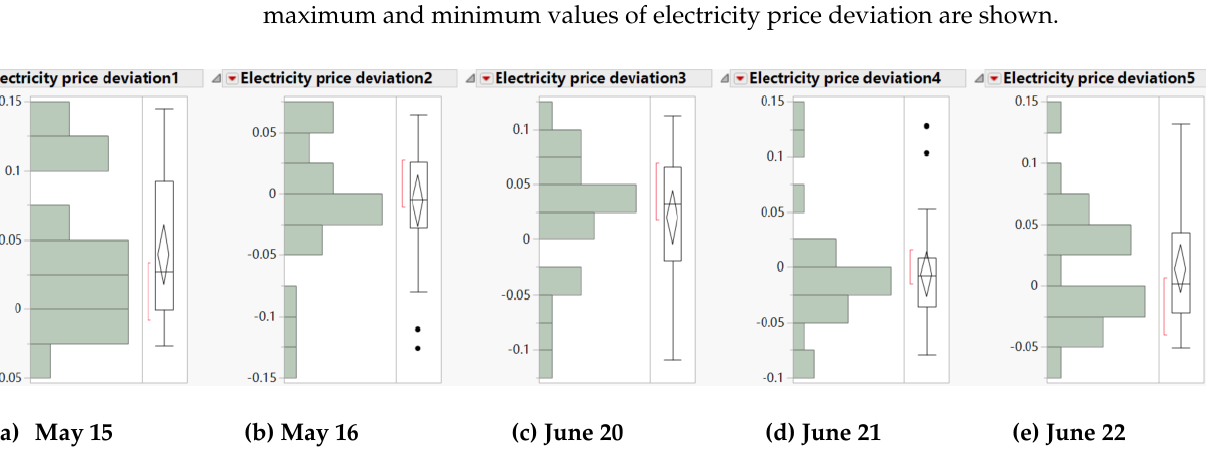
Figure 19. Distribution of deviation between DA electricity price and RT electricity price. Table 11. Deviation range of trial operation electricity price and corresponding recovery